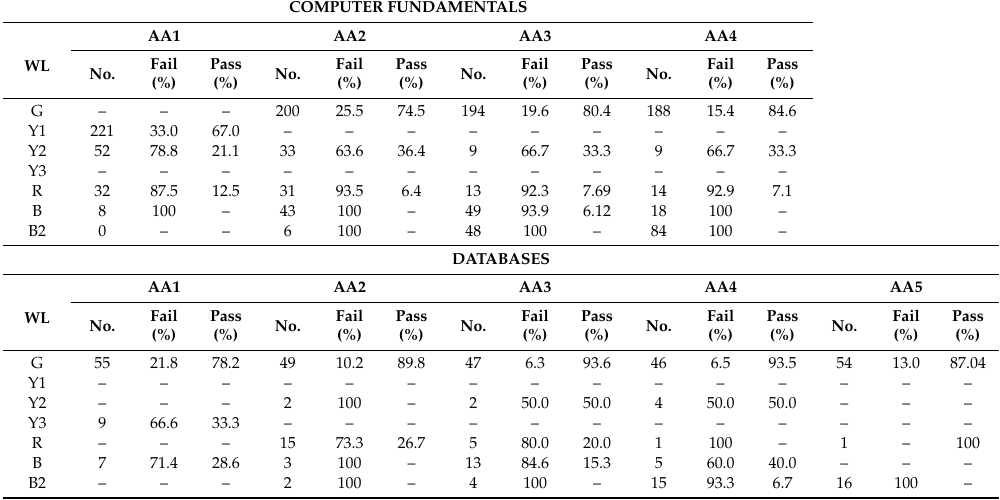
Table 5. Performance of the warning level where WL are the di ff erent warning levels defined in Figure 7, No. is the number of students identified in that risk, Fail is the percentage of students identified in that risk that failed the course and Pass is the percentage of students in that risk that passed the